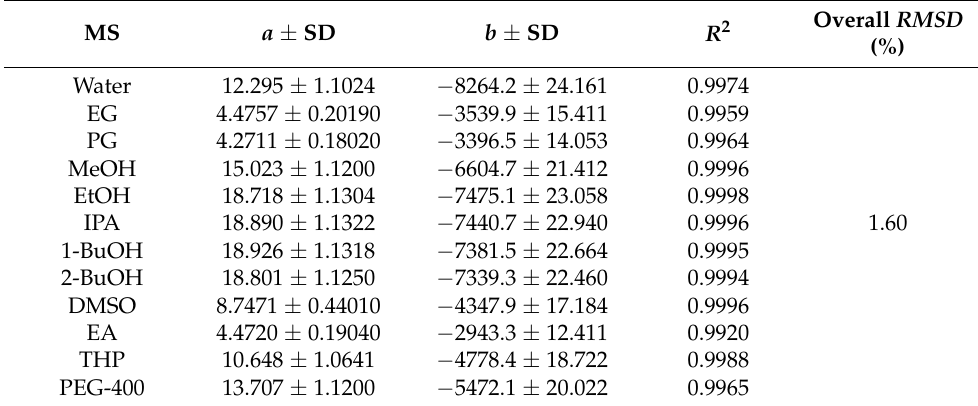
Table 5. van’t Hoff model results for FBX in several MS in terms of model parameters ( a and b ), R 2 , and RMSD